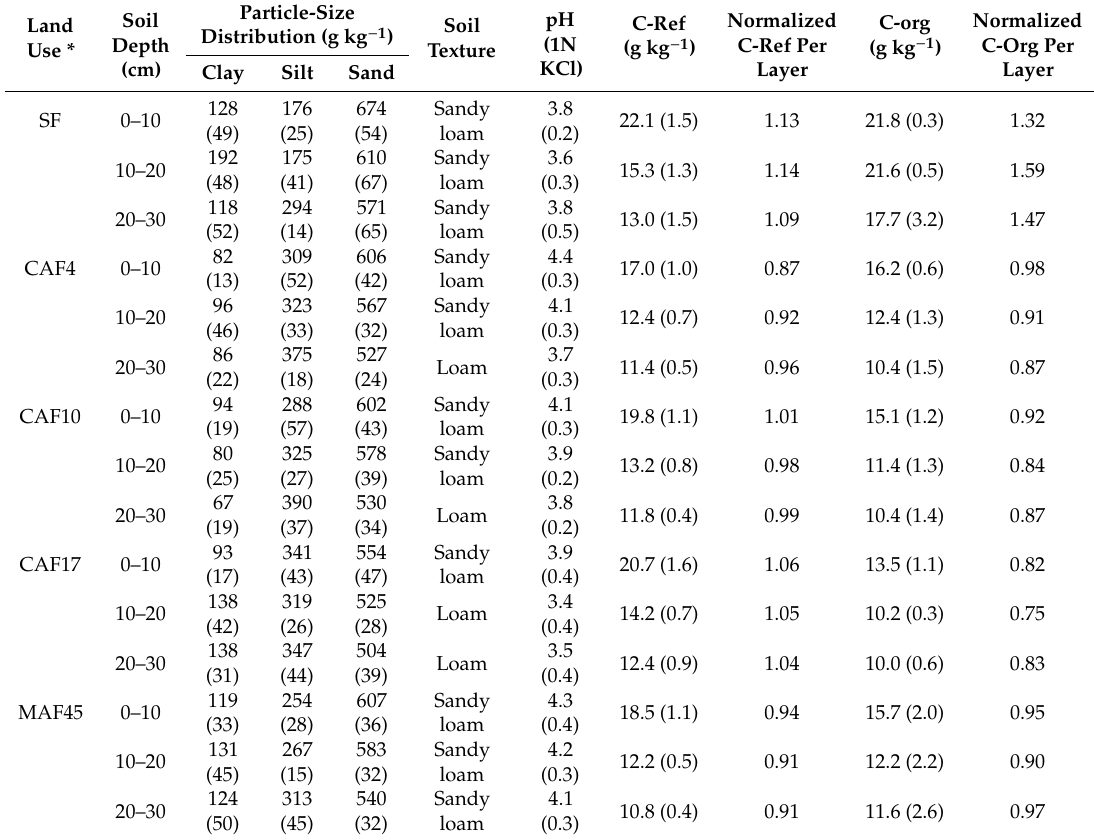
Table 1. Particle–size distribution (USDA classification), pH and derived reference organic carbon concentration (C-ref, responding to texture and pH) of the soil to a depth of 30 cm, as test of homogeneity of the sample sites used for the five land uses; values in brackets are standard errors of the means of four measurements; for C-ref and measured C-org, the values are also provided after normalization on the mean across land uses per soil